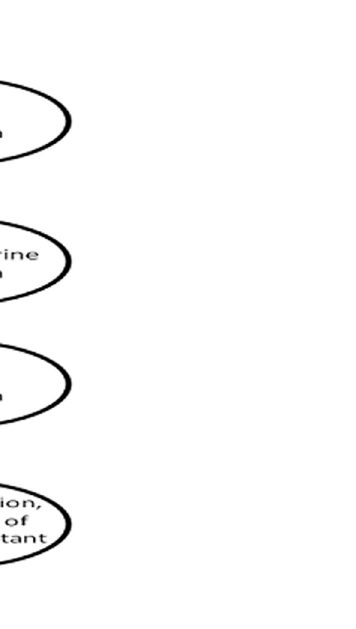
Fig 2. Course of the